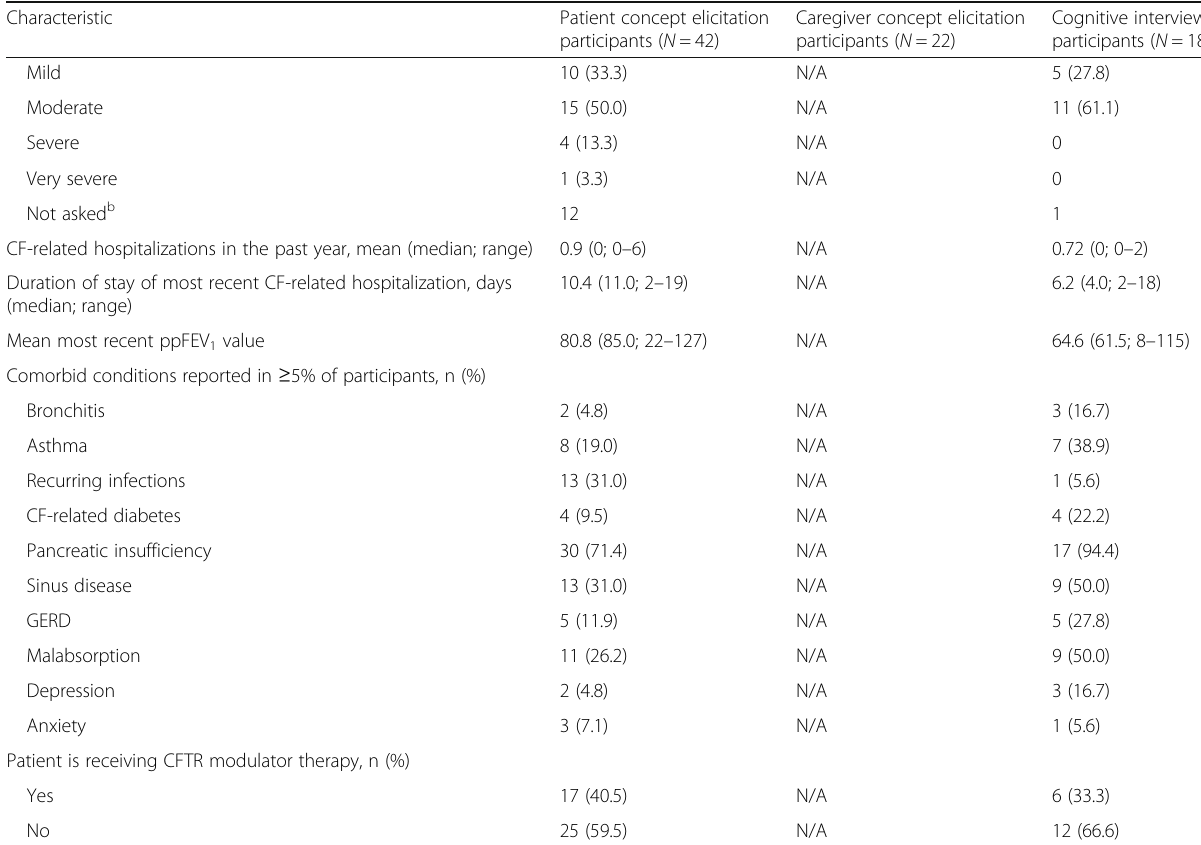
Table 1 Participant demographic and clinical characteristics (Continued)